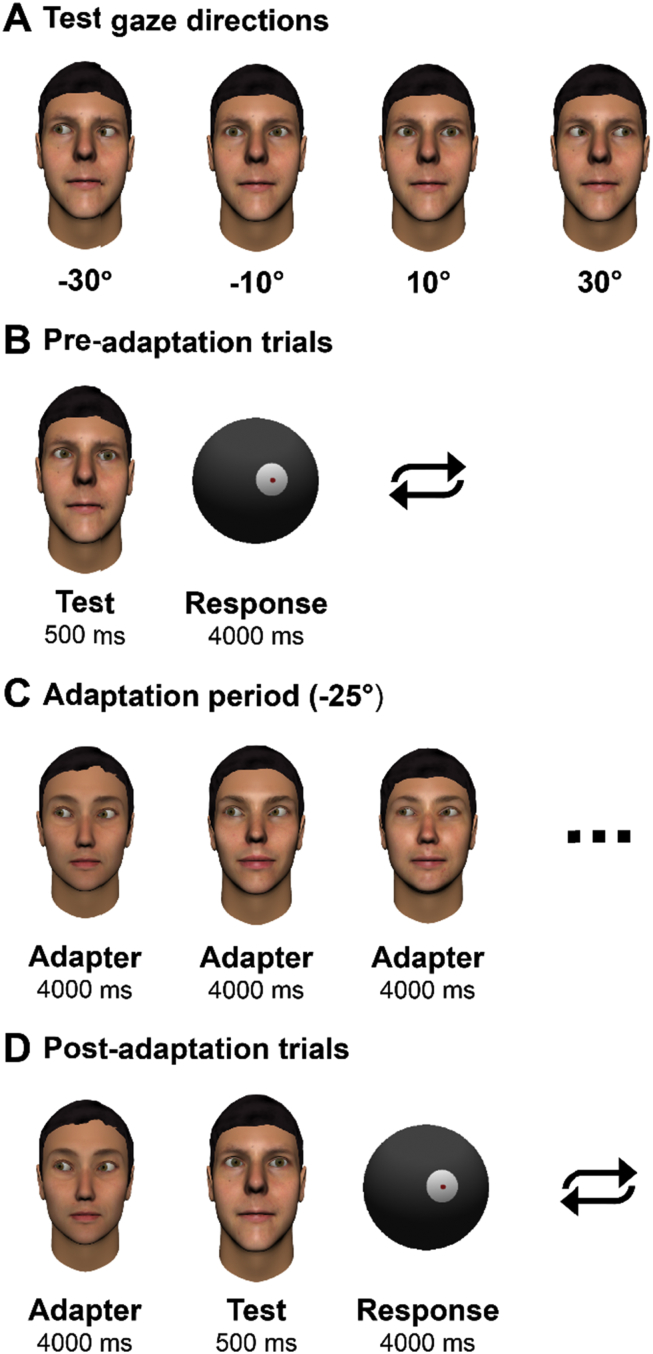
Task for measuring the psychophysical effects of sensory adaptation to gaze direction. (A–B) In a pre-adaptation test of gaze perception, participants were shown a series of faces with different horizontal directions of gaze, shown here for one of the six identities used. Participants indicated the direction in which each face was looking using a spherical pointer displayed on screen. (C) Participants were adapted to 25° averted gaze by viewing a series of faces with this direction of gaze for 4 sec each for a total of 1 min. (D) Following adaptation, participants were tested on their perception of the test stimuli again. In post-adaptation trials, participants were also shown ‘top-up’ adapter images to maintain adaptation throughout the task.